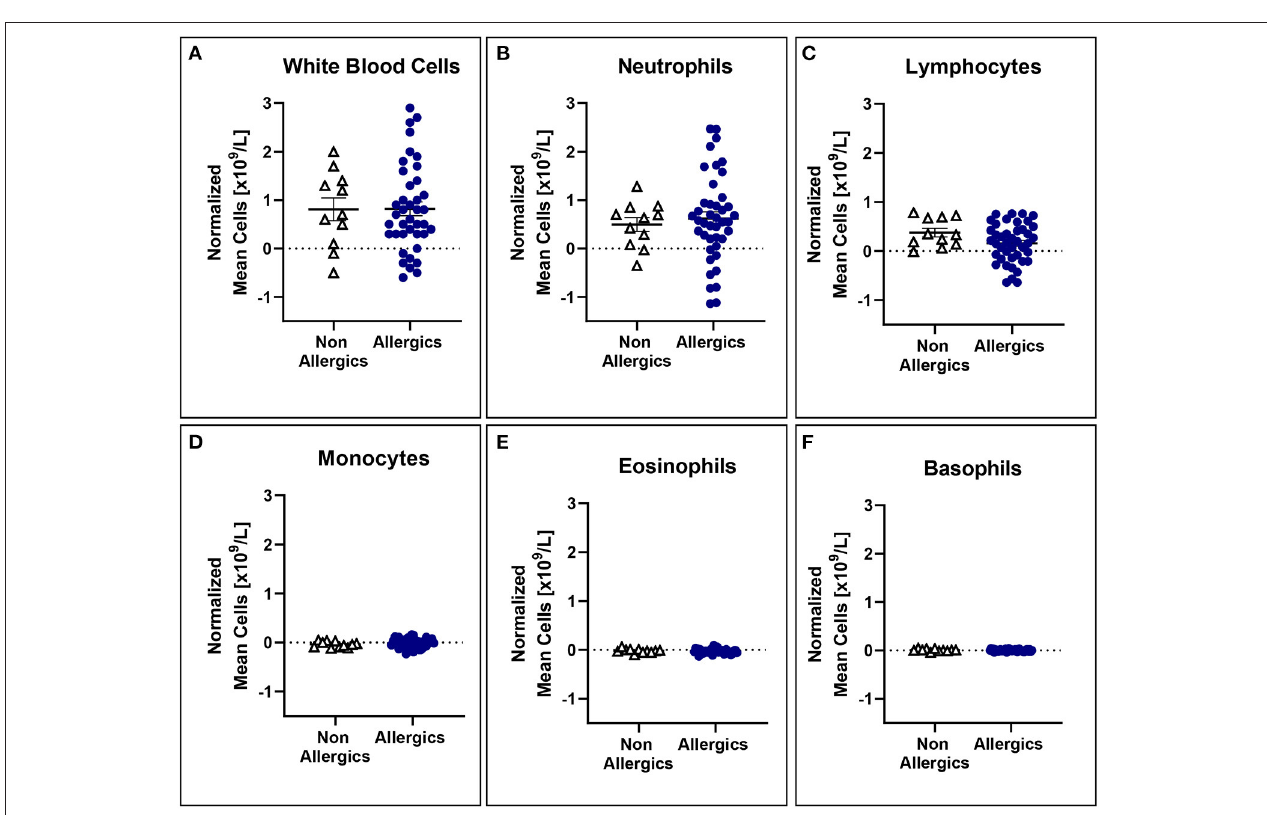
FIGURE 5 | White blood cell counts normalized to baseline are comparable for both allergic and non-allergic participants. No significant differences were observed in white blood cell (A) , neutrophil (B) , lymphocyte (C) , monocyte (D) , eosinophil (E) , and basophil (F) counts normalized to baseline in the peripheral blood.